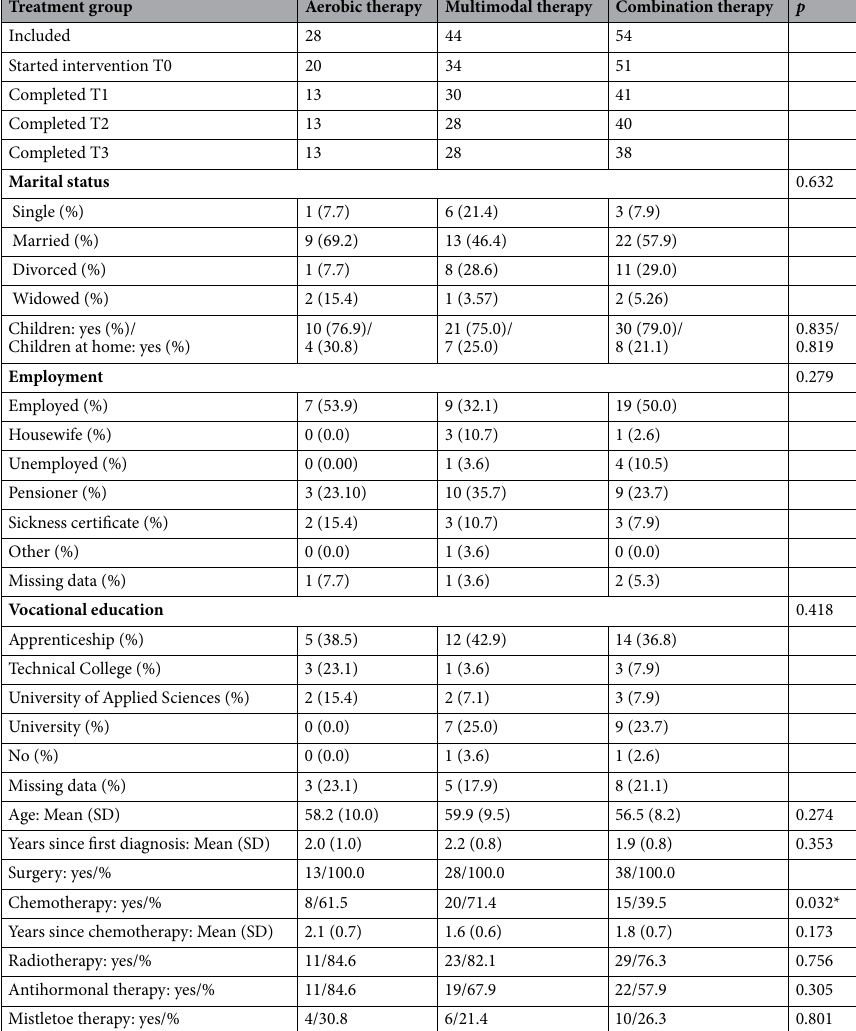
Table 1. Socio-demographic characteristics at baseline (T0) for patients participating at the 4 years follow-up (T3), n = 79. Numbers and percentages relating to patients who completed T3 (n = 79), *: p < 0.05. SD standard